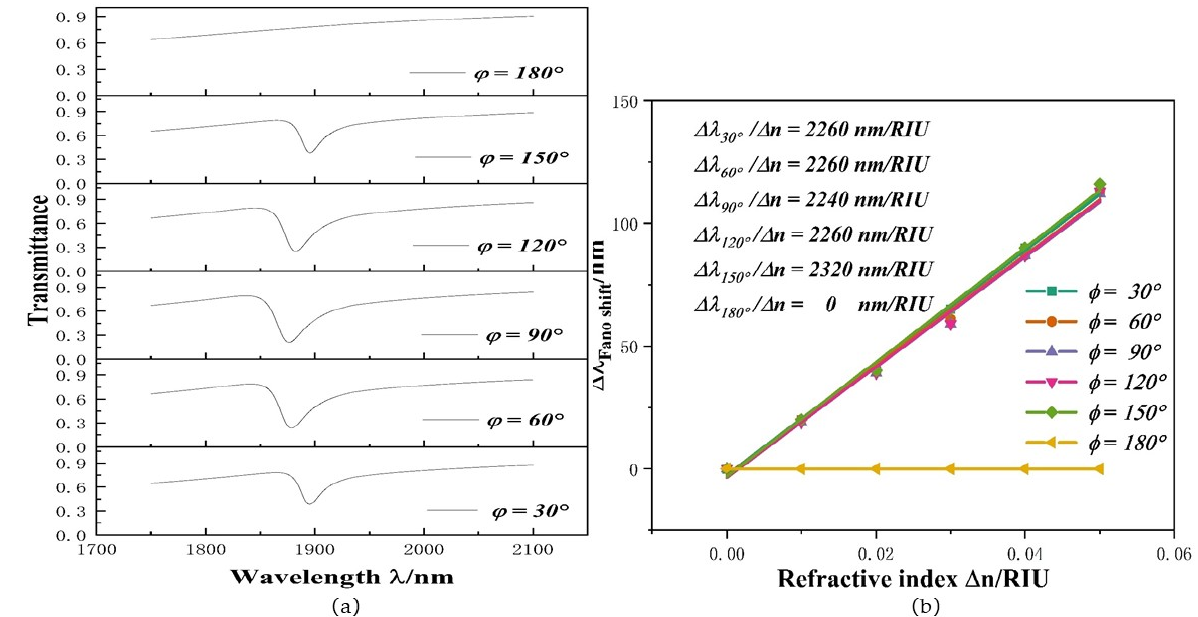
Figure 6. ( a ) Transmission spectra at various angles; ( b ) S changes under different angles. Moreover, we studied the influence of the g parameter on system performance, set- ting it as follows: g = 5 nm, 10 nm, 15 nm, 20 nm, and 25 nm. As can be observed from Figure 7a, the curve is blueshifted, and its transmittance increased significantly. The rea- son for this is that as g increases, the coupling strength of ORRS and stub-1 weakens, re- sulting in an increase in transmittance at the dip. This alone does not mean that the mini- mum g value should be selected to ensure transmittance. When g = 5 nm, the transmittance is as low as 0.05, but the curve is too large. Subsequently, the impact of different heights of stub-1 was also investigated. The h was changed from 120 nm to 160 nm at intervals of 10 nm, and its transmission spectra are shown in Figure 7b. With the increase in h , the position of the dip hardly changes but the transmittance decreases from 0.2573 to 0.1682. When the transmittance value is 0.1682, the sensitivity value is 2180 nm/RIU. Therefore, the appropriate FOM and S value can be selected by changing h . Figure 7. ( a ) Transmission spectra at disparate coupling distances; ( b ) Transmission spectra for dif- ferent height of stub-1.